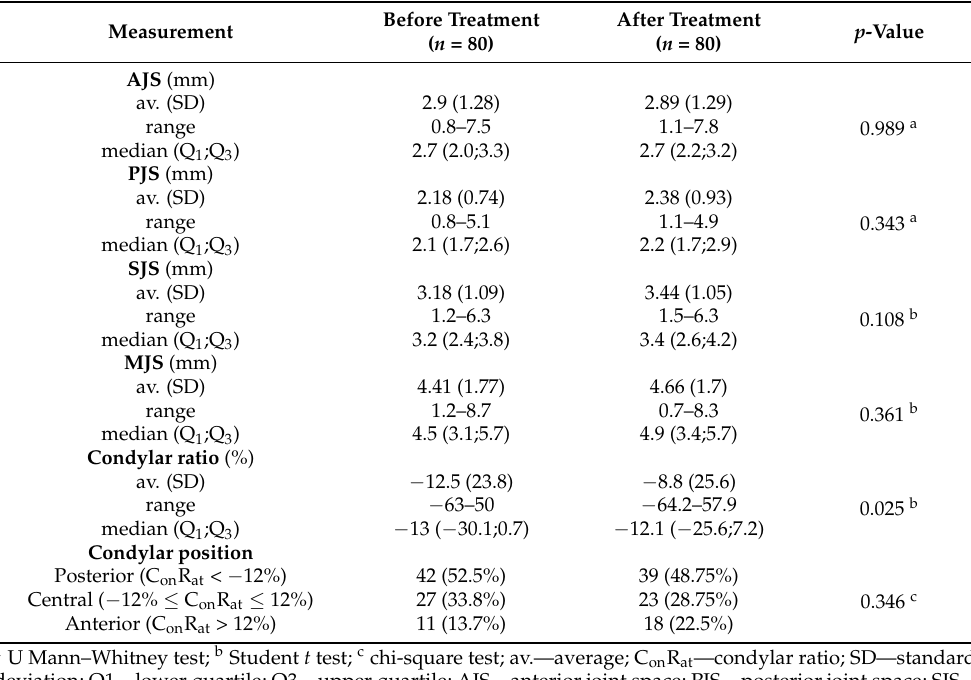
Table 7. The average values of different joint spaces and condylar ratio before and after the end of the treatment in the study group.